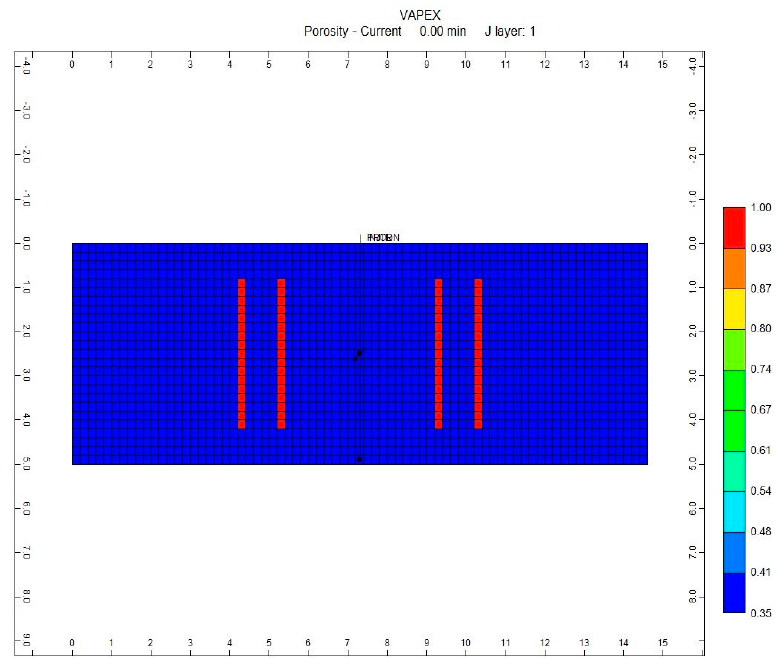
Figure 7. History matching results in the base case scenario.